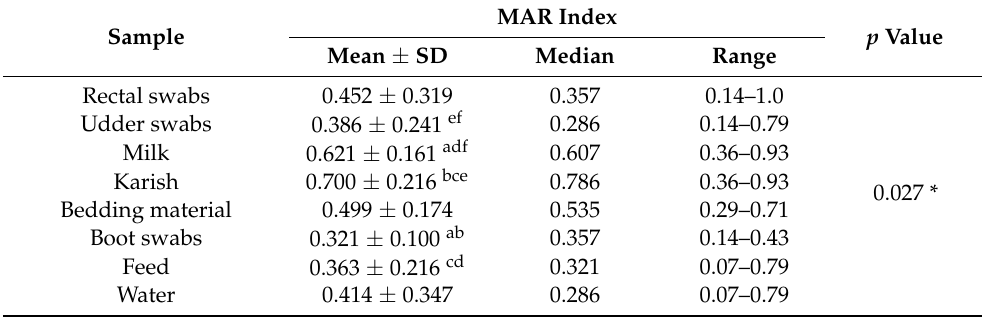
Table 6. Mean ± SD, median, and range of MAR index for samples from different